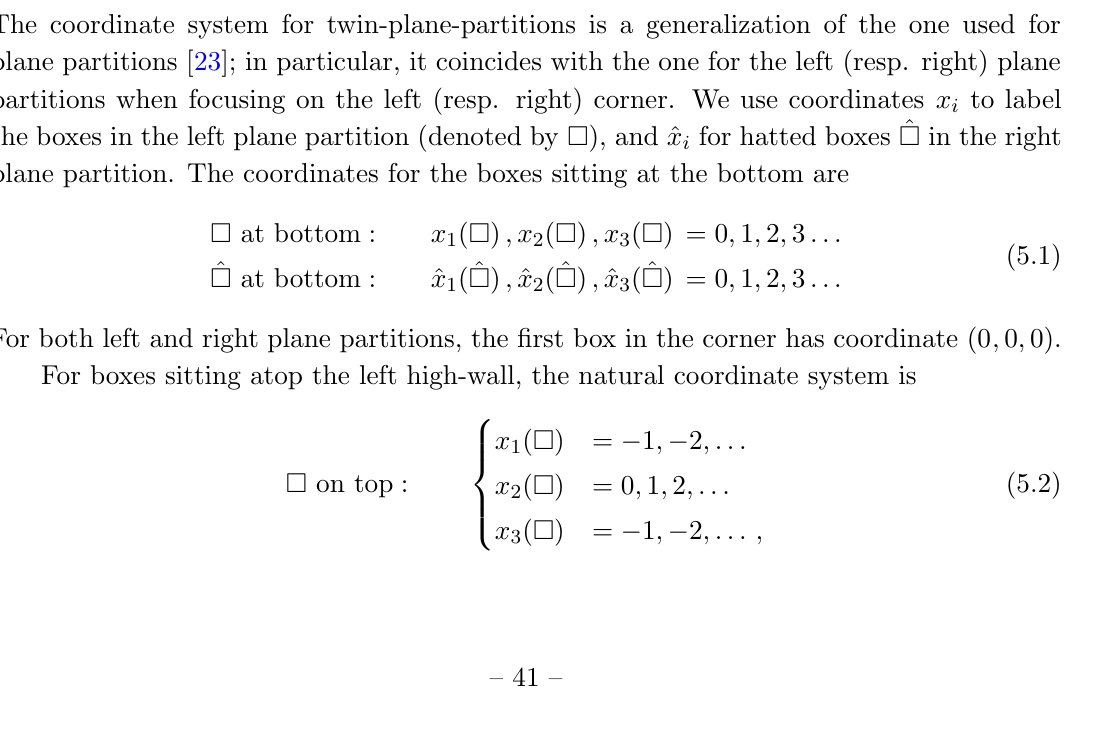
(cid:24) ^ x direction are 2 2